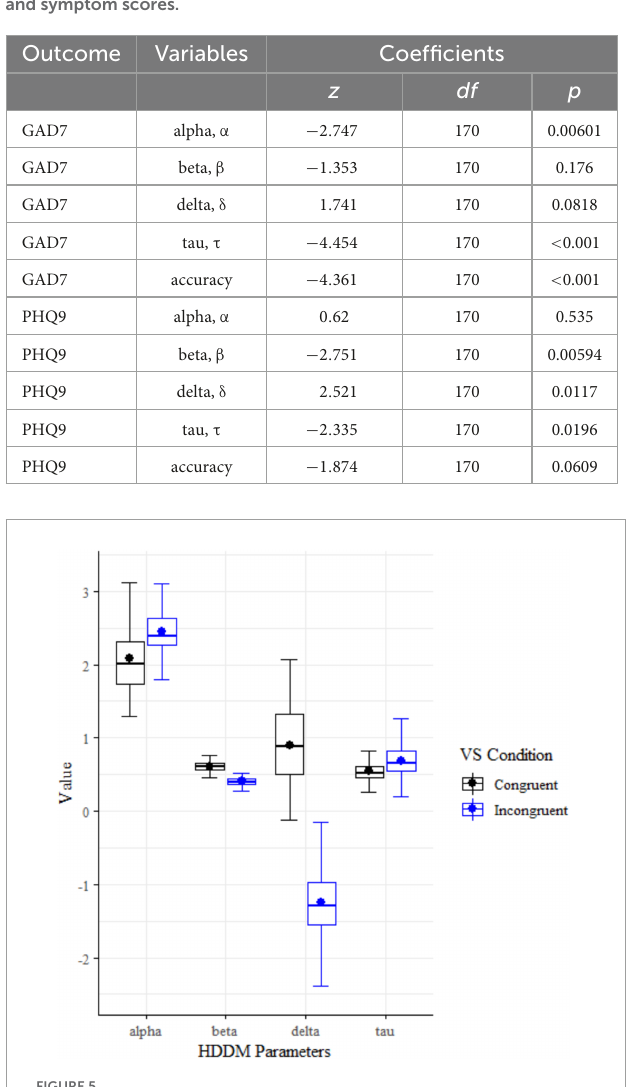
FIGURE5 HDDM cognitive parameter box plots for Visual Search conditions.